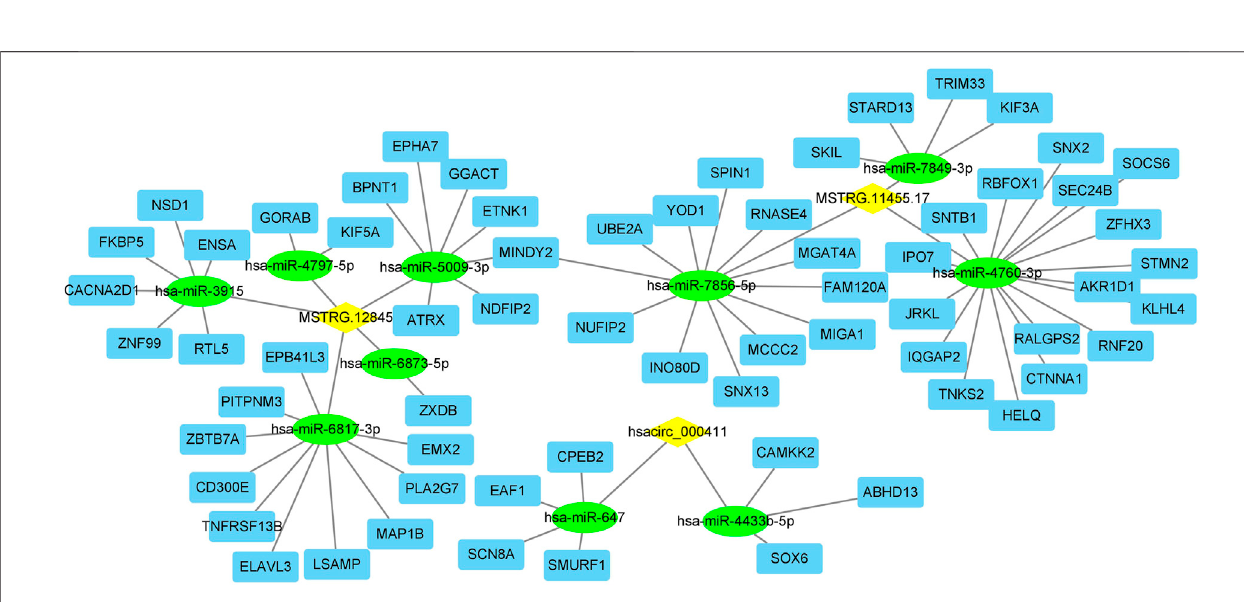
Frontiers in Genetics |